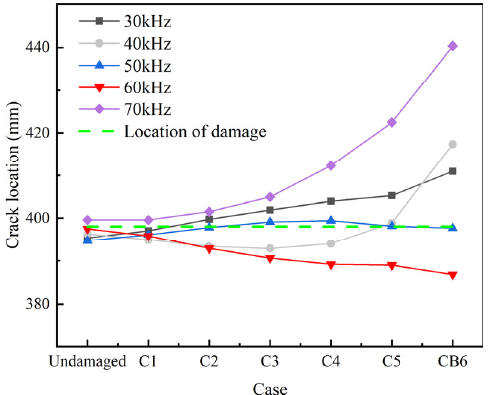
Figure 15. Crack location. Figure 15. Crack